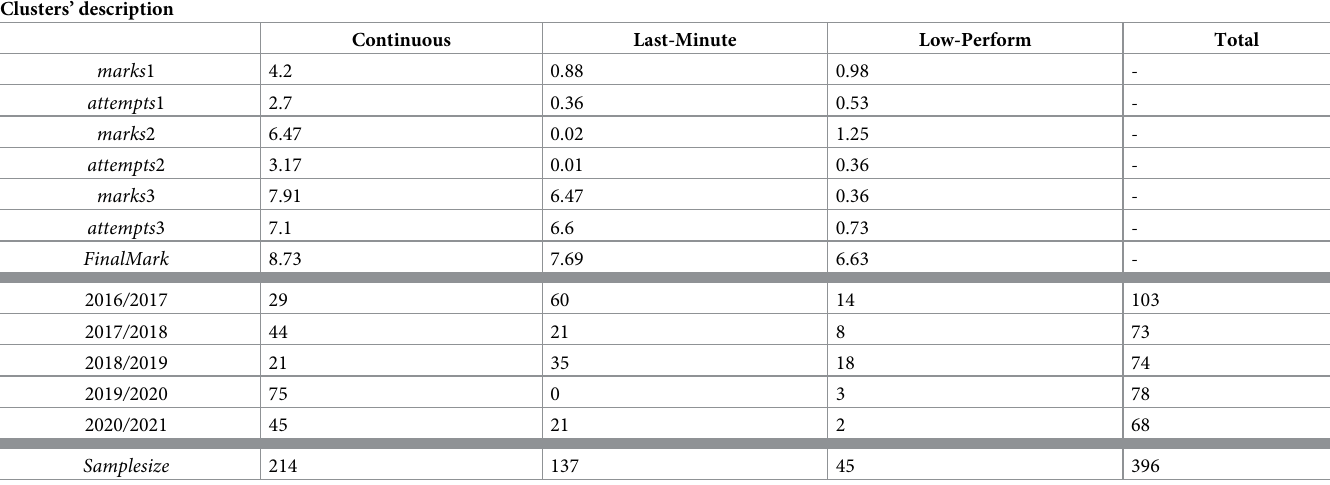
Table 3. Description of the three clusters using hierarchical clustering. Mean is used for the dataset attributes for each cluster. Clusters’ description